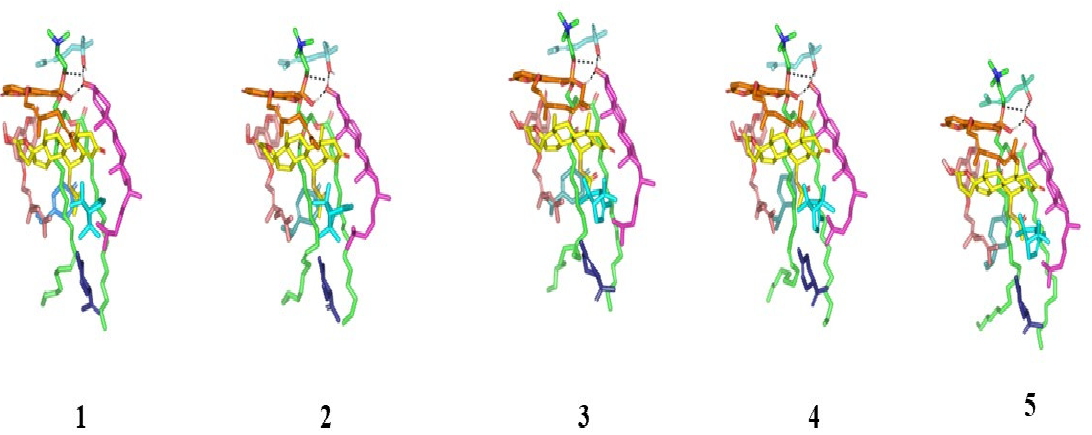
Figure 4. Conformational time evolution of PC-FC-BEO NPs across the all-atom molecular dynamics simulation. Thermodynamic movements of formulation components: SP (yellow) loaded on PC interface (green), COL (magenta), LIN (faint blue), LIM (dark blue), GTP (marine). Abbreviations: BEO: bergamot essential oil, NPs: nano-phytosomes, SP: spironolactone, PC: phosphatidylcholine, COL: cholesterol, LIM: limonene, LIN: linalool, GTP: γ -terpinene, 1 (0.2 ns), 2 (0.4 ns), 3 (0.6 ns), 4 (0.8 ns), and 5 (1.0